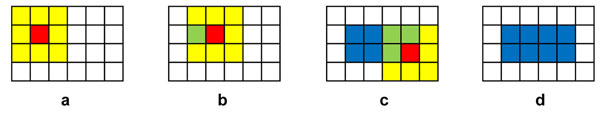
Consecutive steps of using window when calculating measures from GLCM. (a) 3x3 window (yellow and red pixels) in initial position; measures calculated from GLCM for this window are than saved in corresponding matrix in the position denoted by red pixel; (b) Next position of the window; green pixel is a pixel for which measures have been saved and it is again taken for the calculations in the window; (c) Last position of the window; (d) Blue pixels denote positions for which measures were calculated.